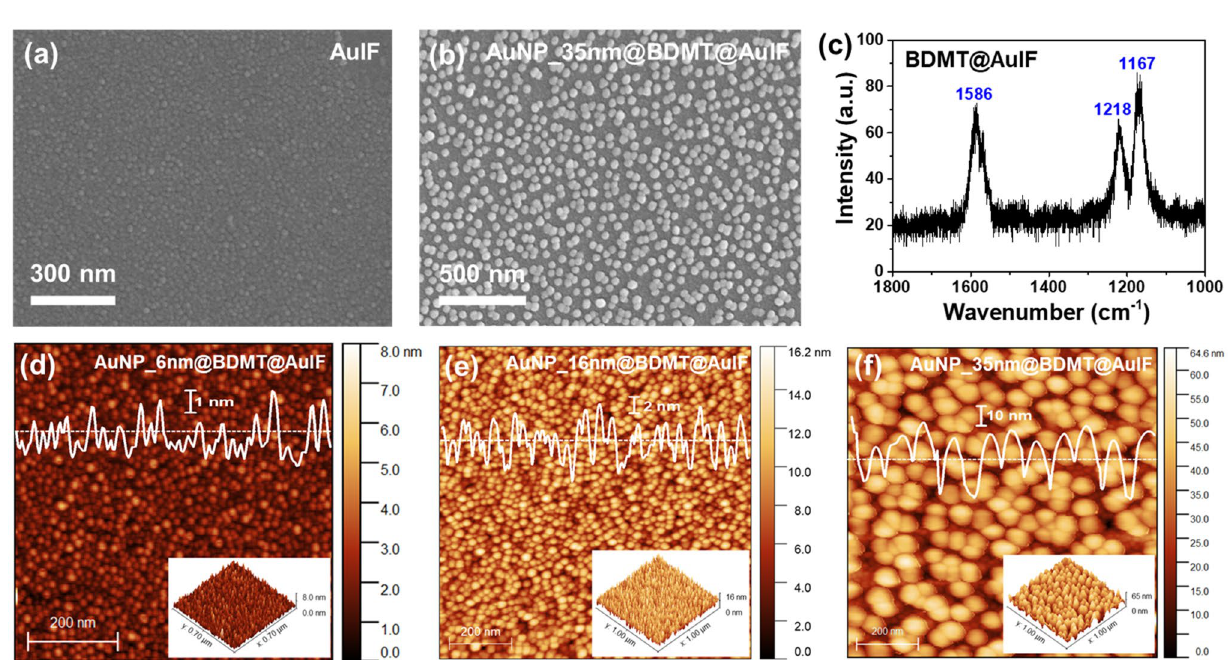
Figure 3. Morphological and chemical properties of the AuNPs@BDMT@AuIF. ( a ) and ( b ) SEM images of the AuIF and the AuNP_35nm@BDMT@AuIF, respectively. ( c ) Raman spectrum of the BDMT@AuIF. The characteristic peaks of 1586, 1218, and 1167 cm − 1 corresponds to ring stretching, CH 2 wagging, and β C–H vibration modes of the BDMT SAMs, respectively. ( d )–( f ) AFM images of the AuNPs@BDMT@AuIF with different diameters of AuNPs. The white line profile inserted in each AFM image represents the height information along the